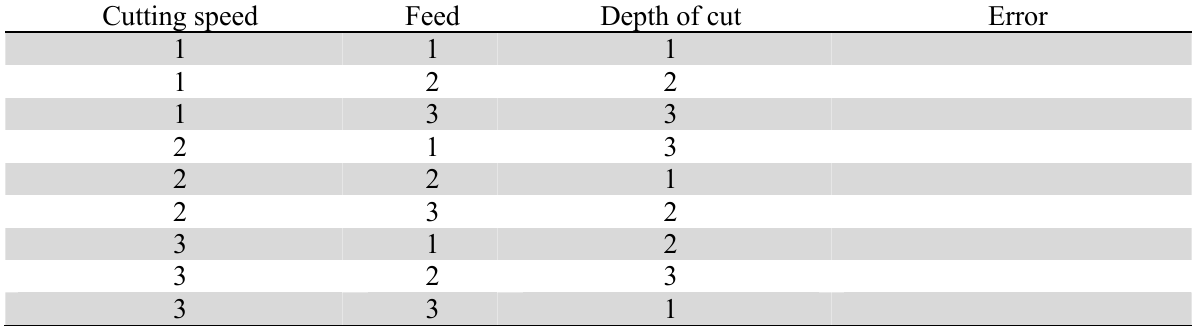
(3 3 ) orthogonal array 9